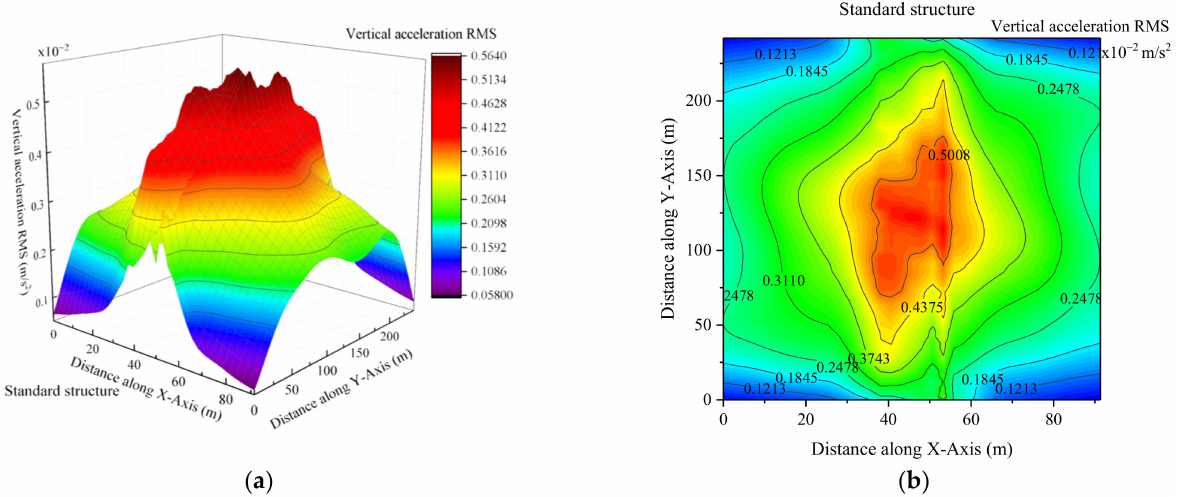
Figure 16. Color chart of the vibration RMS for the standard structure. ( a ) 3D diagram; ( b ) verti- cal view.